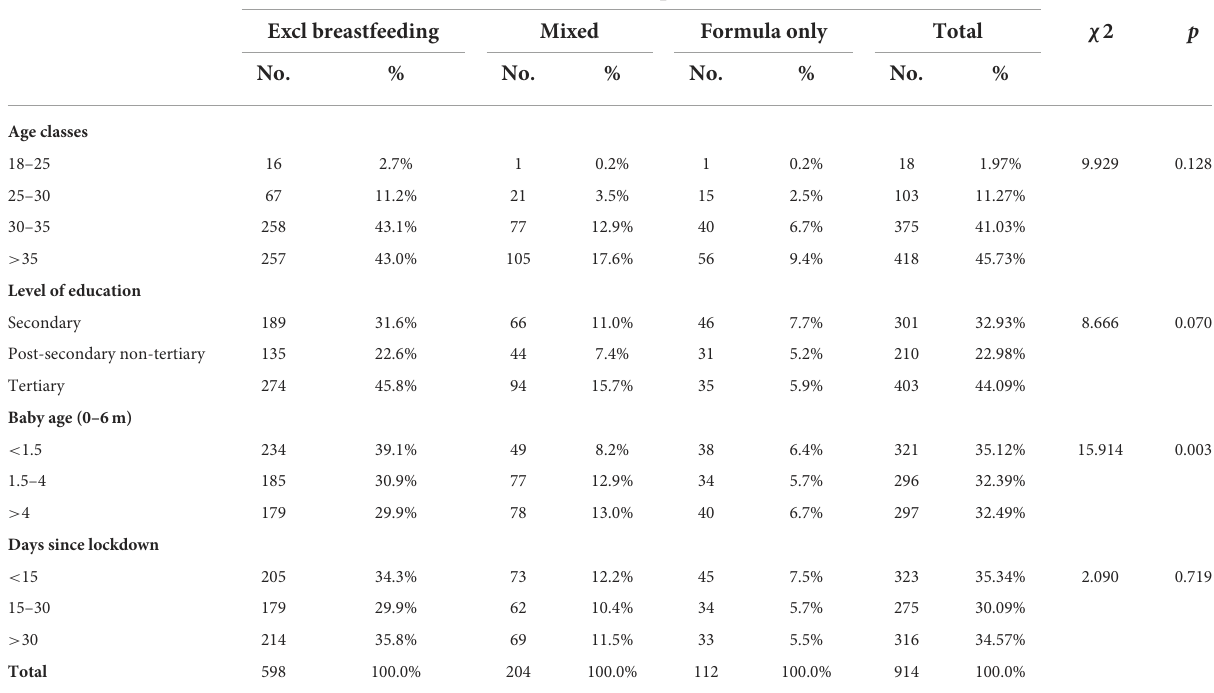
TABLE 1 Characteristics of the